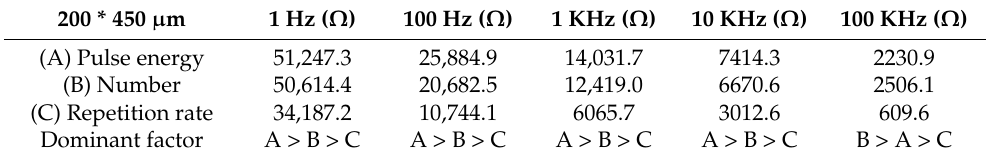
Table 4. The range analysis data for 200 * 450 µ m rectangular template.